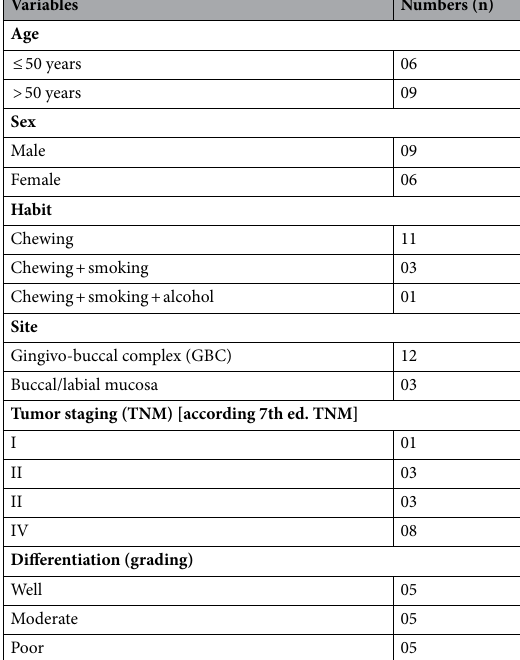
Table 1. Clinicopathological features of samples of OSCC for POSTN, TNC, CAV1, FSCN1 for Proteomic